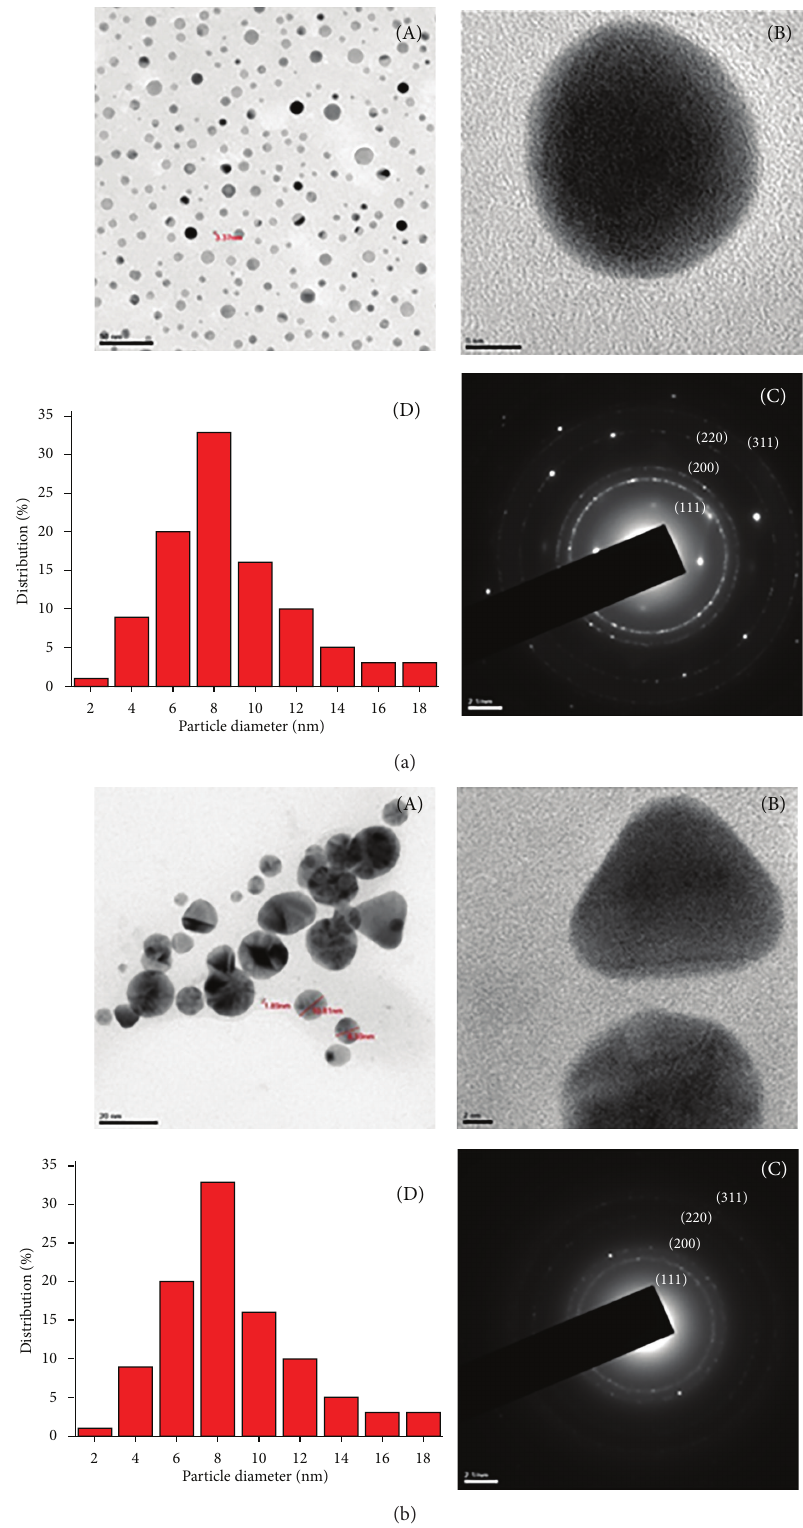
Figure 5: HRTEM images of Ag NPs (a) and Au NPs (b); different magnifications (A) and (B); SAED pattern (C); particle size distribution